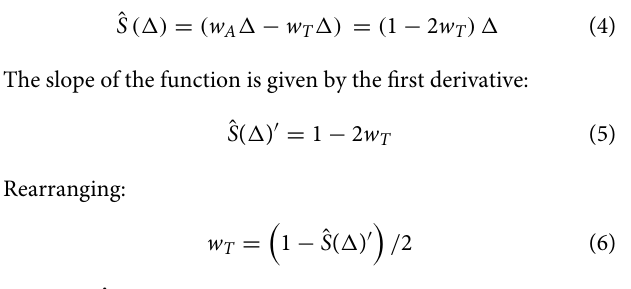
Frontiers in Integrative Neuroscience |